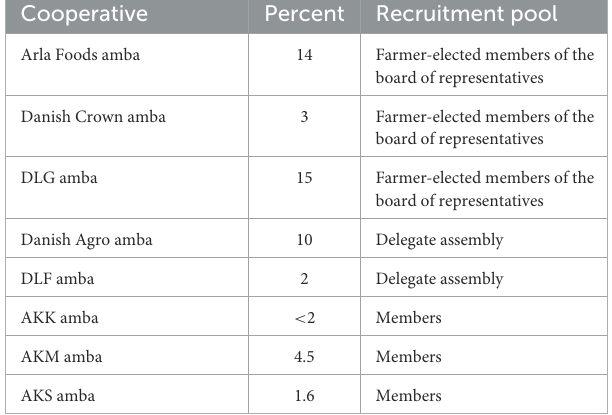
TABLE 3 Women’s shares (percent) of members in farmer-owned cooperatives (2022 or recent years).